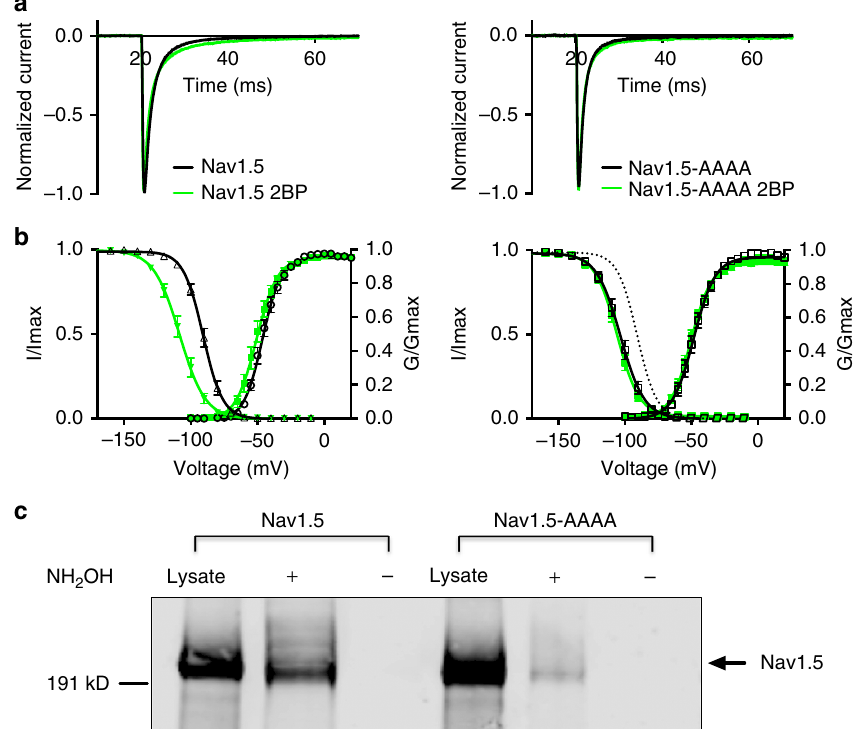
Figure 7 | Effects of chemical inhibition of palmitoylation on the biophysical properties of wild-type Nav1.5 and Nav1.5-AAAA. Black lines and open symbols indicate data from control conditions and green indicates data from the 2-Br-palmitate(2BP) treatment group. ( a ) Normalized currents from cells transfected with Nav1.5 (left) and Nav1.5-AAAA (right) with and without 2BP treatment. n ¼ 7. ( b ) Comparison of wild-type Nav1.5 (left) and Nav1.5- AAAA (right) channel voltage dependence of activation and steady-state inactivation before (black) and after (green) channel depalmitoylation. The dotted line indicates the wild-type Nav1.5 steady-state inactivation. All data are shown as mean ± s.e.m. n ¼ 11. ( c ) Characterization of Nav1.5-AAAA palmitoylation using ABE method. The reduced signal of Nav1.5-AAAA in ‘ þ ’ lane (hydroxylamine treated) indicates largely reduced palmitoylation of Nav1.5-AAAA. The results are representative of at least three independent